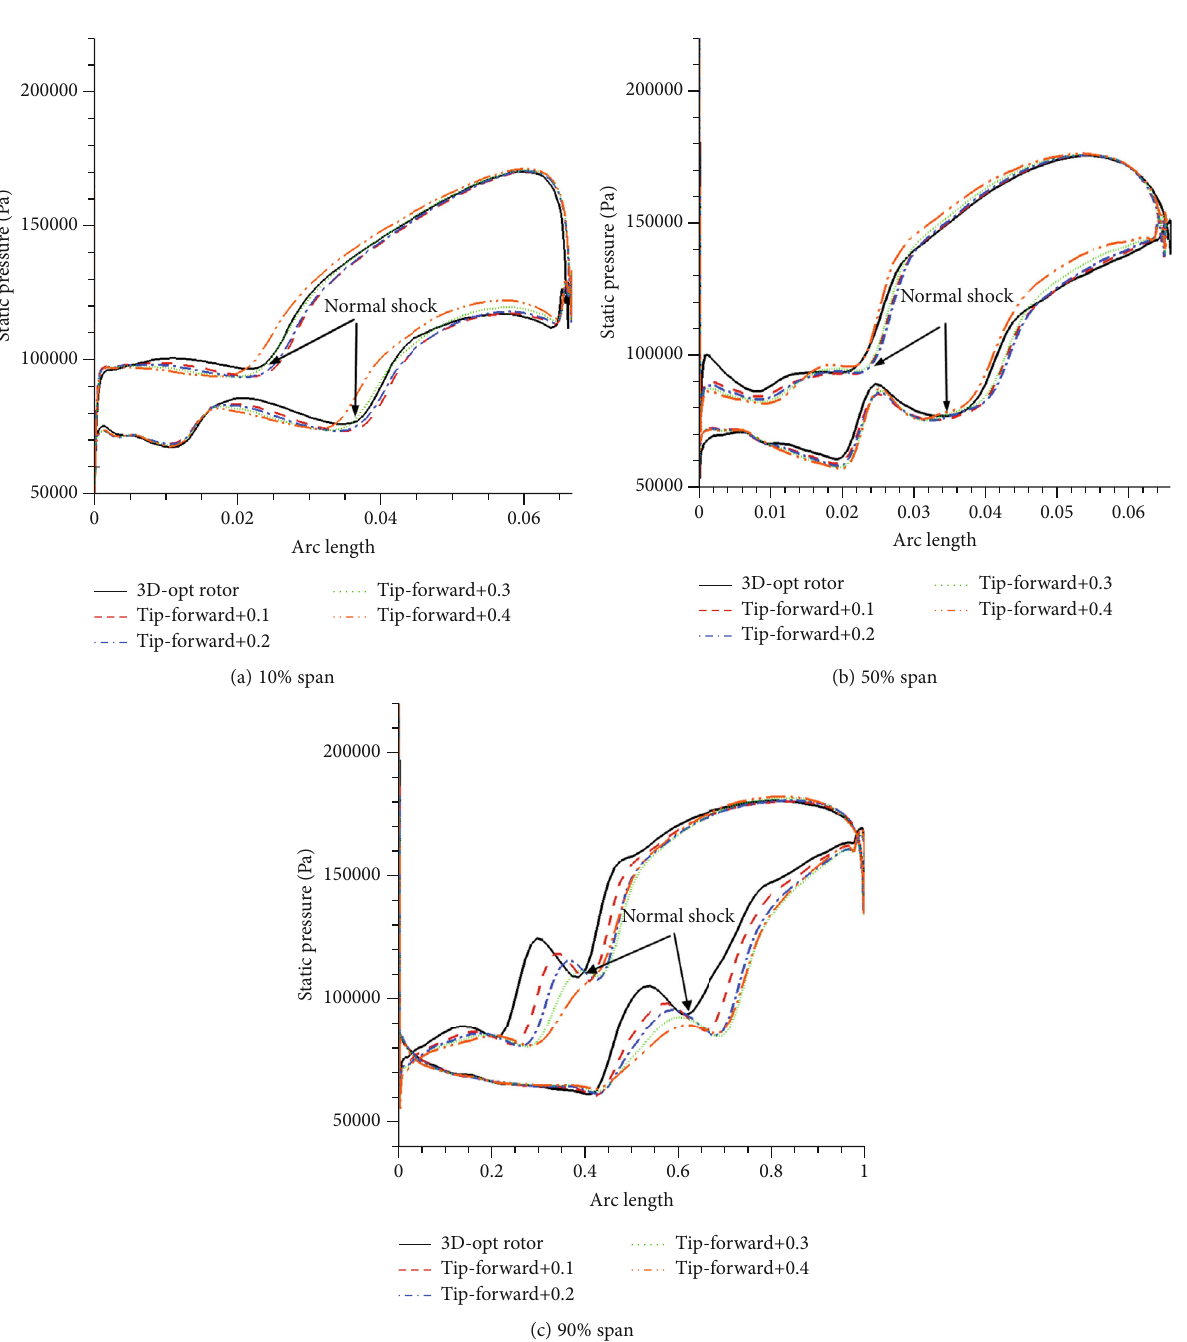
Figure 21: Static pressure distribution on the surface of fi ve blades at the design